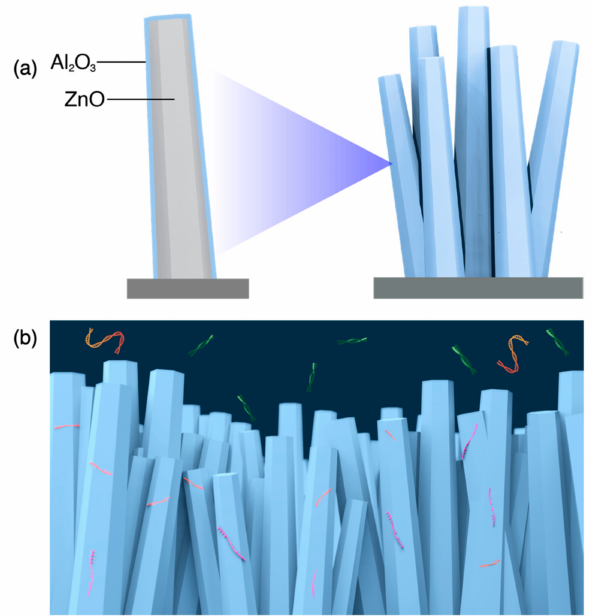
Figure 1. Schematic illustrations. ( a ) ZnO/Al 2 O 3 core-shell nanowire. ( b ) Capture of miRNAs and mRNAs on nanowire structures; other nucleic acids are not